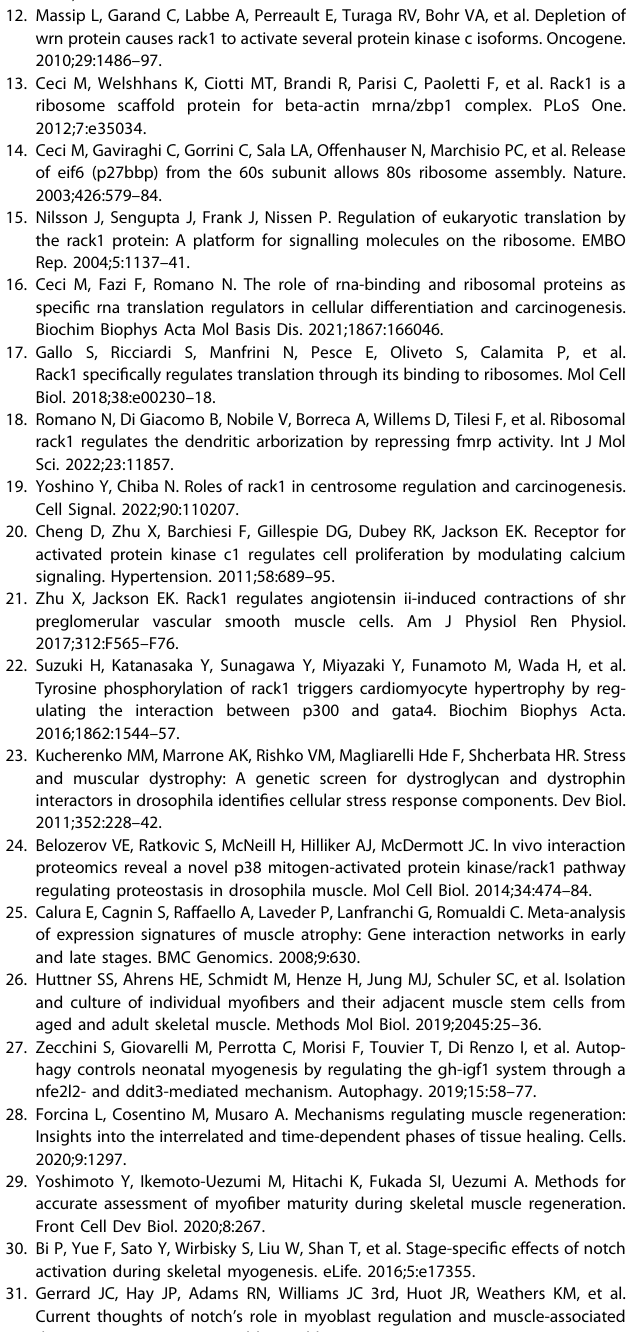
Fig. 8 RACK1 downregulation affects D. melanogaster muscle regeneration. A , D Confocal fl uorescence imaging of Phalloidin (blue) or TO- PRO (red) in DLM longitudinal sections of Mef2-Gal4/Zfh1-Gal4 (controls) and Mef2>RACK1 IR/Zfh1>RACK1 IR fl ies after physical damage at increasing times, and B , E time-course measurement of the wound area. Results are expressed as percentage of the wound area of the respective strain measured just after damage ( t = 0 h, dotted line). **** P < 0.0001 vs Mef2>RACK1 IR/Zfh1>RACK1 IR. Images and quantitative data are representative of 20 ≤ n ≤ 30 fl ies. C , F Confocal fl uorescence imaging of Jagged1 (green) and RACK1 (red) in DLM longitudinal sections of Mef2-Gal4/Zfh1-Gal4 (controls) and Mef2>RACK1 IR/Zfh1>RACK1 IR fl ies 5 days after physical damage. Lower panels: mean Jagged1 intensity signals (A.U.: arbitrary units) around the injury. *** P < 0.001 vs the respective control. Images are representative of 10 ≤ n ≤ 15 fl ies. G Confocal fl uorescence imaging of ATF4 (red) and Phalloidin (blue) in DLM longitudinal sections of Zfh1-Gal4 (controls) and Zfh1>RACK1 IR fl ies 5 days after physical damage. Images are representative of 10 fl ies. Scale bars: 20